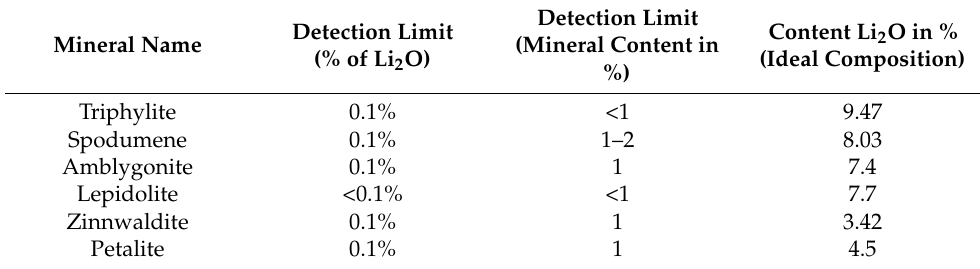
Table 5. Detection of lithium in six different lithium-minerals and their detection limits.